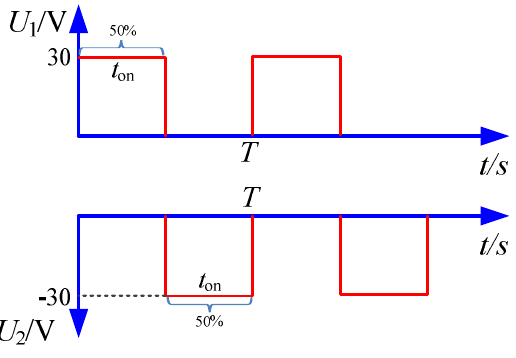
Figure 3. The waveform used in the simulation. Table 1. The parameters for the simulation.